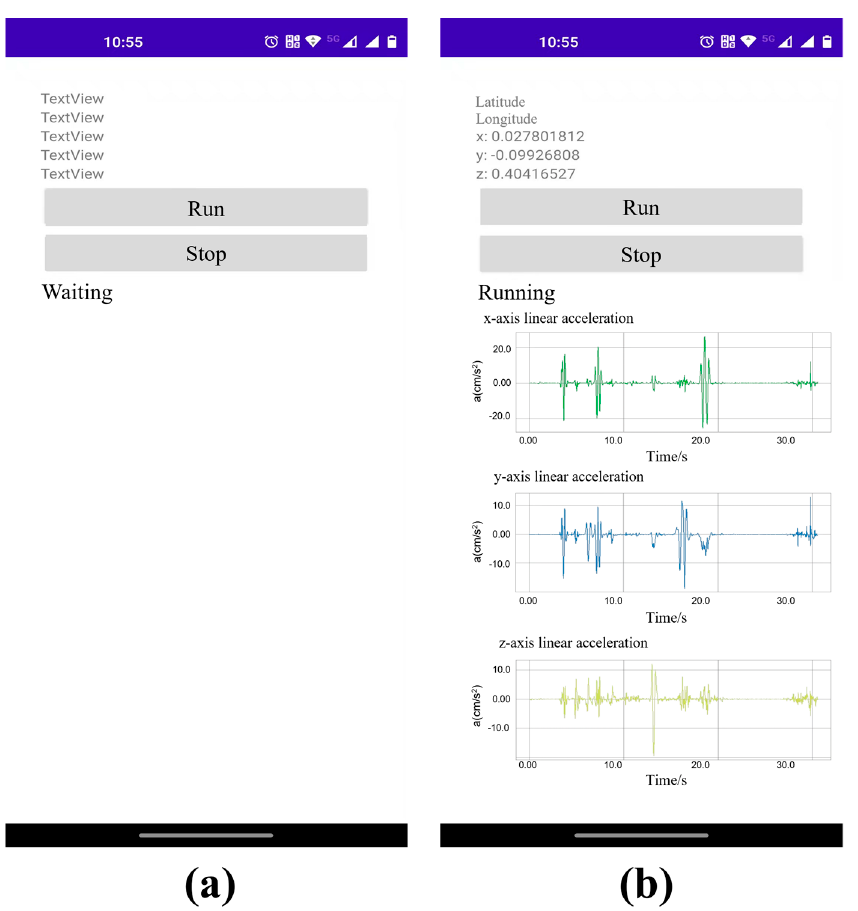
Figure 2. Mobile phone acceleration acquisition application: ( a ) acceleration test waiting interface; ( b ) acceleration acquisition interface.